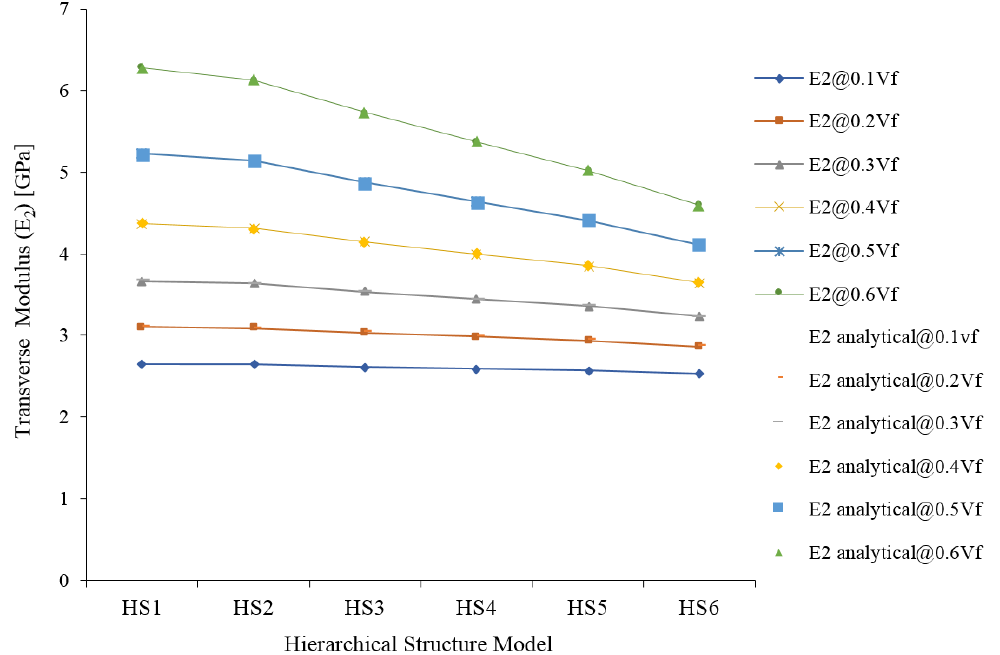
Figure 11. Transverse Modulus (E 2 ) of jute fiber reinforced composite. The in-plane shear modulus (G 12 ) is not changed with HS (Figure 12). The magnitude of G 12 magnitude increases with increasing fiber percentage; however, the influence of HS is negligible on this property. This means that increasing lumen percentage or decreasing cellulose is not affected by final G 12 .